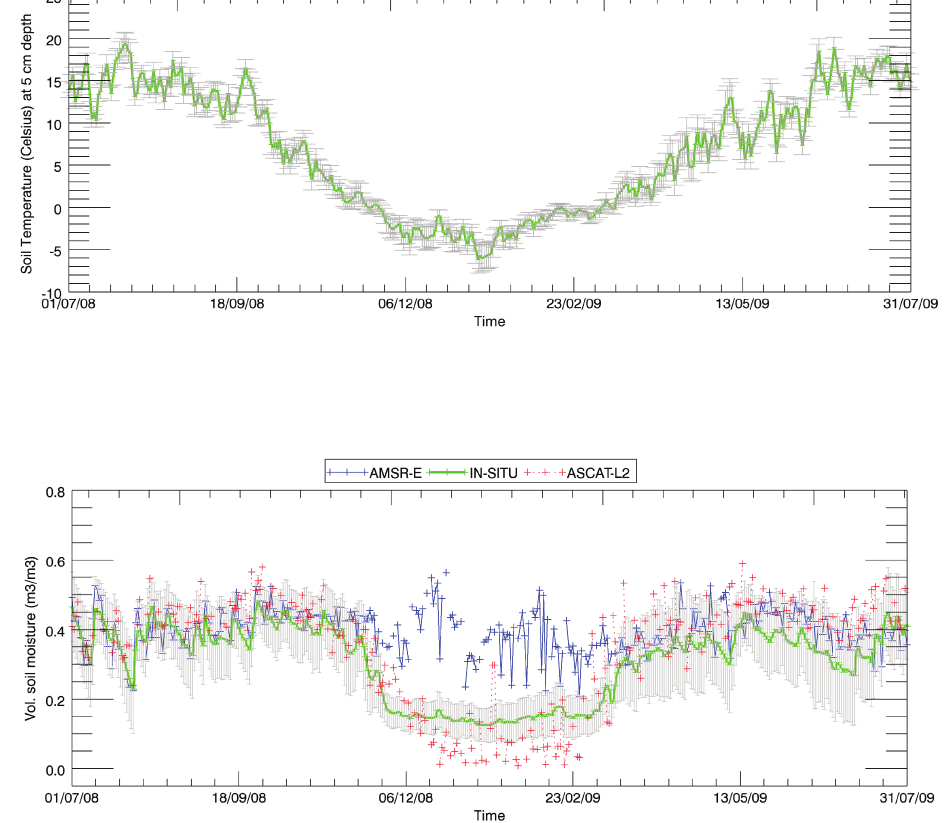
Fig. 5. Calibrated volumetric soil moisture measured at 5cm depth at all Maqu network stations (detailed information for each station is given in Table 2). Figure 5. Calibrated volumetric soil moisture measured at 5 cm depth at all Maqu network 2 stations (detailed information for each station is given in Table 2). 3